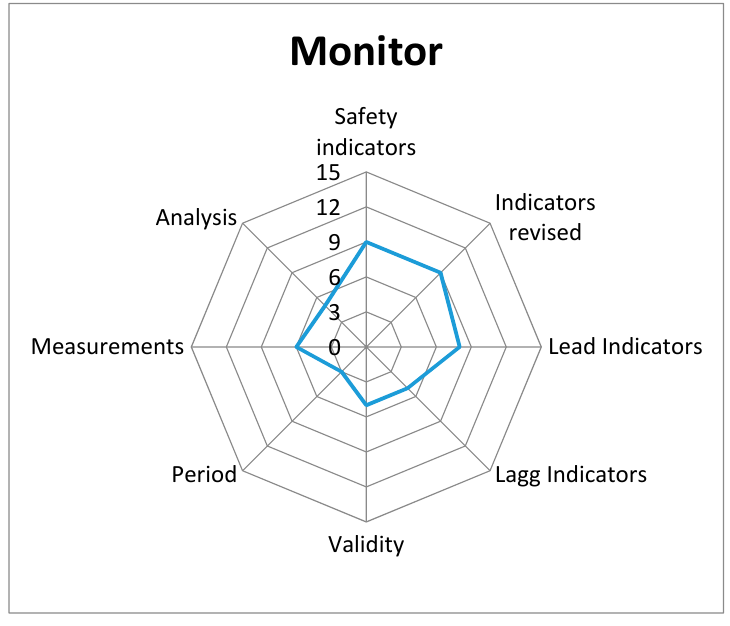
Figure 4. Potential to Monitor—Yes responses.